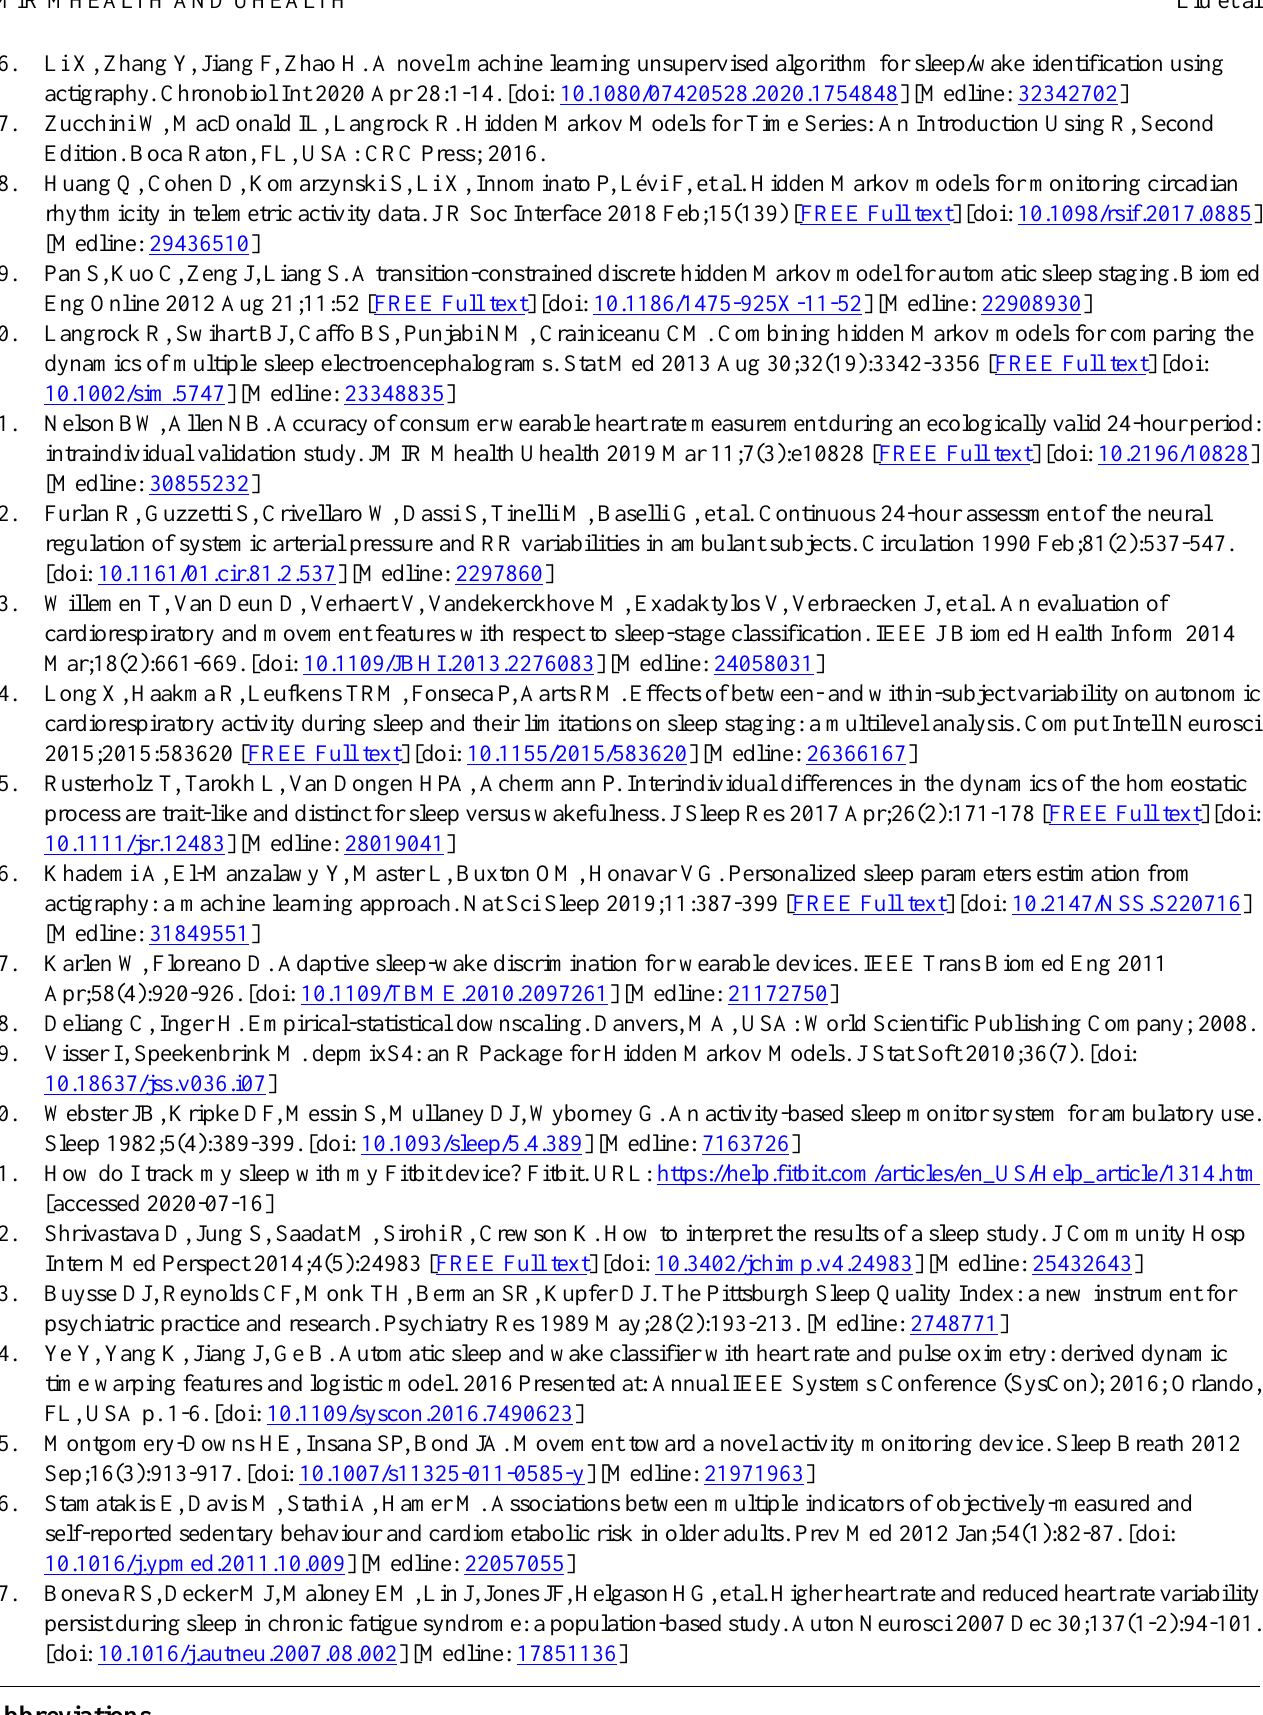
Abbreviations AIC: Akaike information criterion BIC: Bayesian information